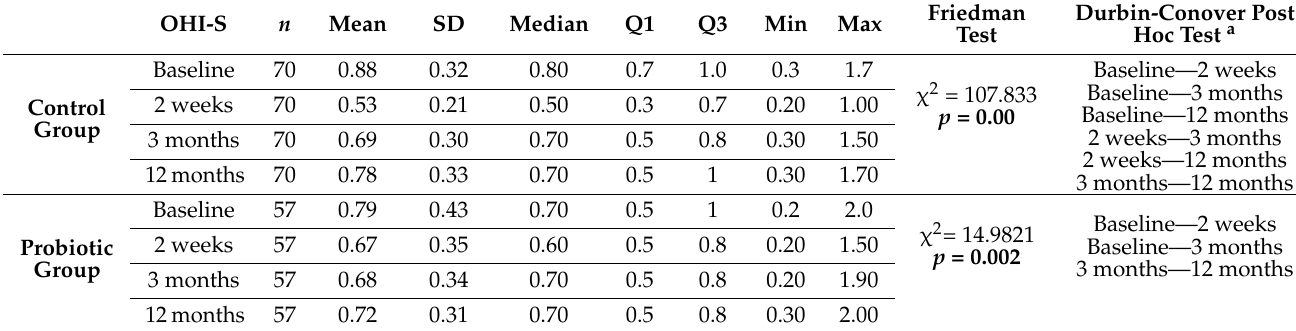
Table 7. Non-parametric Friedman test of OHI-S (Simplified Oral Hygiene Index).